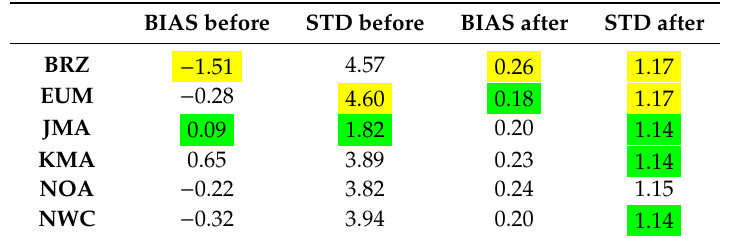
Table 16. Experiment 2: Speed Bias (BIAS) and Speed Standard Deviation (STD) with respect to the NWP analysis winds, before and after the best-fit pressure level correction, for all AMVs for which the best-fit pressure level correction could be applied with QINF >= 80%. The extremes for each category are highlighted; in yellow, the worst value, and in green, the best value. BIAS before STD before BIAS after STD after BRZ − 1.51 4.57 0.26 1.17 EUM − 0.28